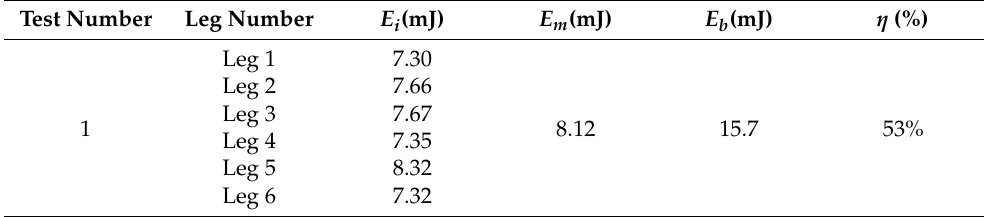
Table 4. Energy efficiency and calculations for linear actuator, moving platform and the machin- ing